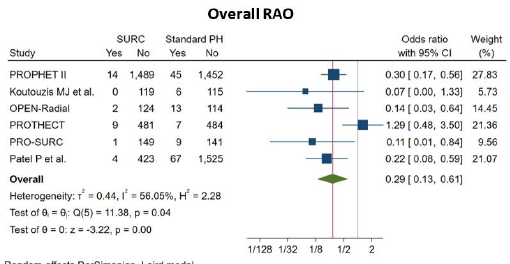
Figure 2. Pooled analysis of studies comparing simultaneous ipsilateral and ulnar artery compression (SURC) versus isolated radial artery compression. Forest plot reporting trial-specific and sum- mary odds ratios (OR) with 95% confidence interval (CI) for the endpoint of overall radial artery occlusion (RAO) at the longest available follow-up. PH, Patent Hemostasis.